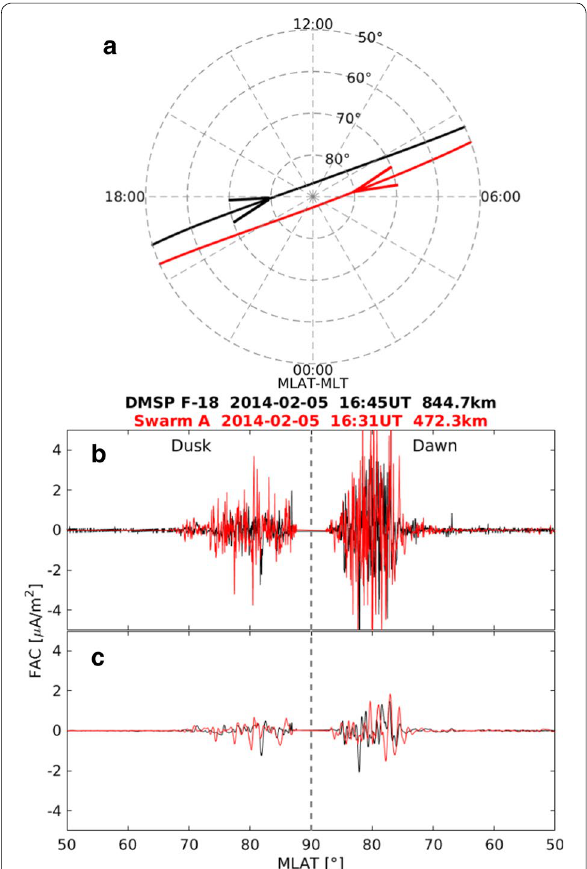
Fig. 3 a The orbit tracks of DMSP (black) and Swarm A (red), and the arrows indicate their flying dirction. b The 1 Hz FAC signatures for the two satellites and c large-scale FACs by appling a low-pass filter with cut-off frequency of 20